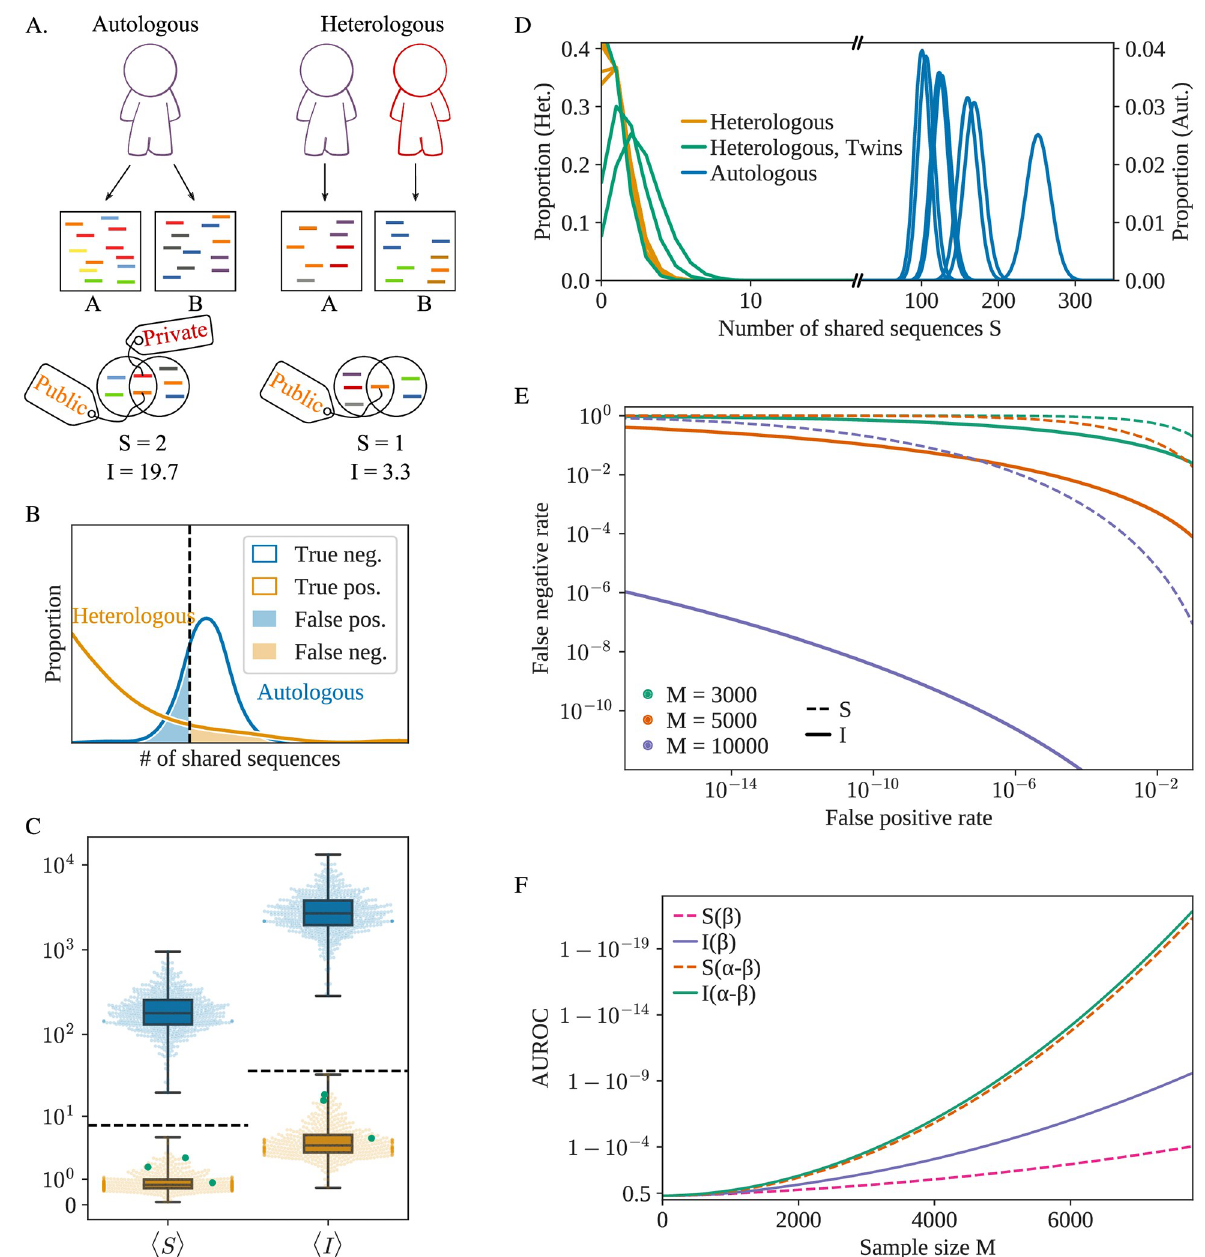
Fig 1. A) The two samples A and B can either originate from the same individual (autologous) or two different individuals (heterologous). In both scenarios, sequences can be shared between the two samples, but their quantity and quality vary. B) Schematic representation of the distribution of the S or I scores for multiple pairs of samples extracted from the same individual (in the autologous scenario) or the same pair of individuals (heterologous). The dashed vertical line represents the threshold value. C) Expected value of S and I for different pairs of samples, sampled from the same individual (in blue) or different ones (yellow). Green dots represent samples extracted from pairs of identical twins. The dashed lines represents the theoretical upper bound for heterologous repertoires (see Methods) for both S and I ( γ = 12). D) Sampling distributions of S for 6 different patients (autologous case, each blue curve is one patient) or 6 different pairs of patients (heterologous, each yellow or green curve is a pair of patients) for M = 5000. The y-axis scale on the left is adapted to the heterologous distributions while the scale on the right corresponds to the (much wider) autologous ones. The 3 sampling distributions in green correspond to a pair of samples extracted from identical twins. E) Detection Error Trade-off (DET) graph for both summary statistics and different sample sizes M . I ( γ = 12) outperforms S in all scenarios. F) AUROC (Area Under Receiver Operating Characteristic), as a function of M . The AUROC is a traditional measure of the quality of a binary classifier (a score closer to one indicates a better classifier). The results are shown for S and I both in the default case (only the β chain considered) or for the full ( α — β )